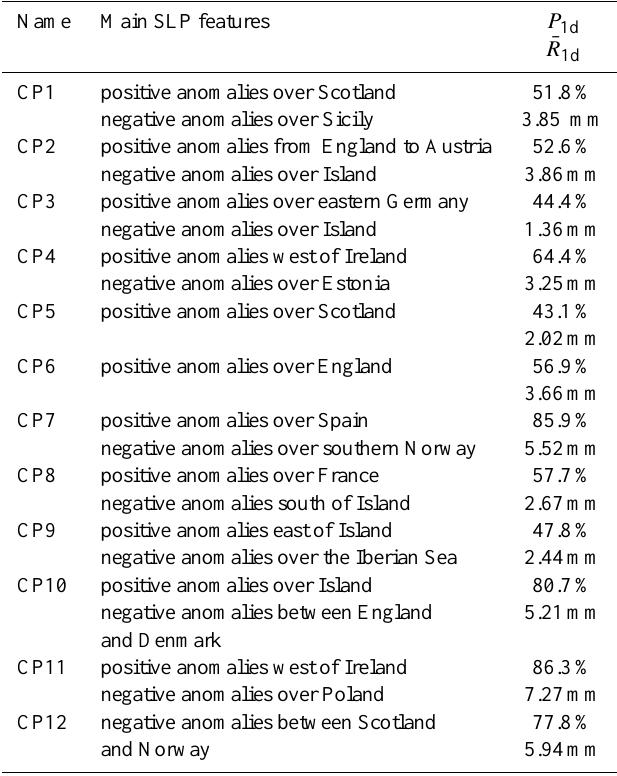
Table 1. Main SLP characteristics of the twelve CPs, average rain day frequency P 1d and average wet day rainfall depth ¯ R 1d with a threshold of R ≥ 0 . 1mm.